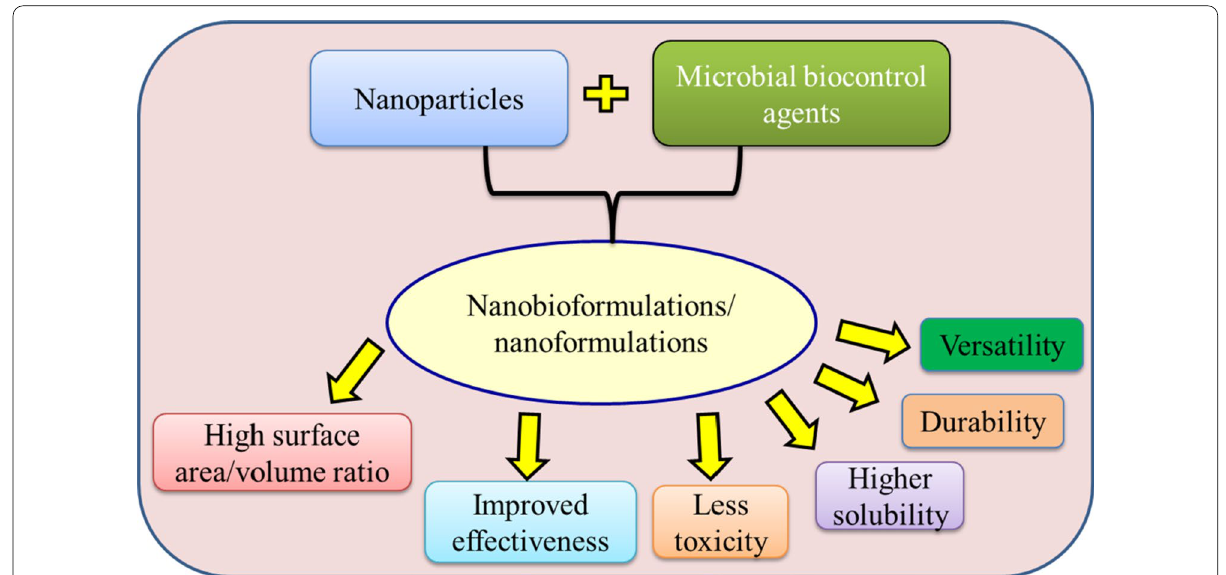
Fig. 1 Advantages of microbial nano-bioformulations for sustainable